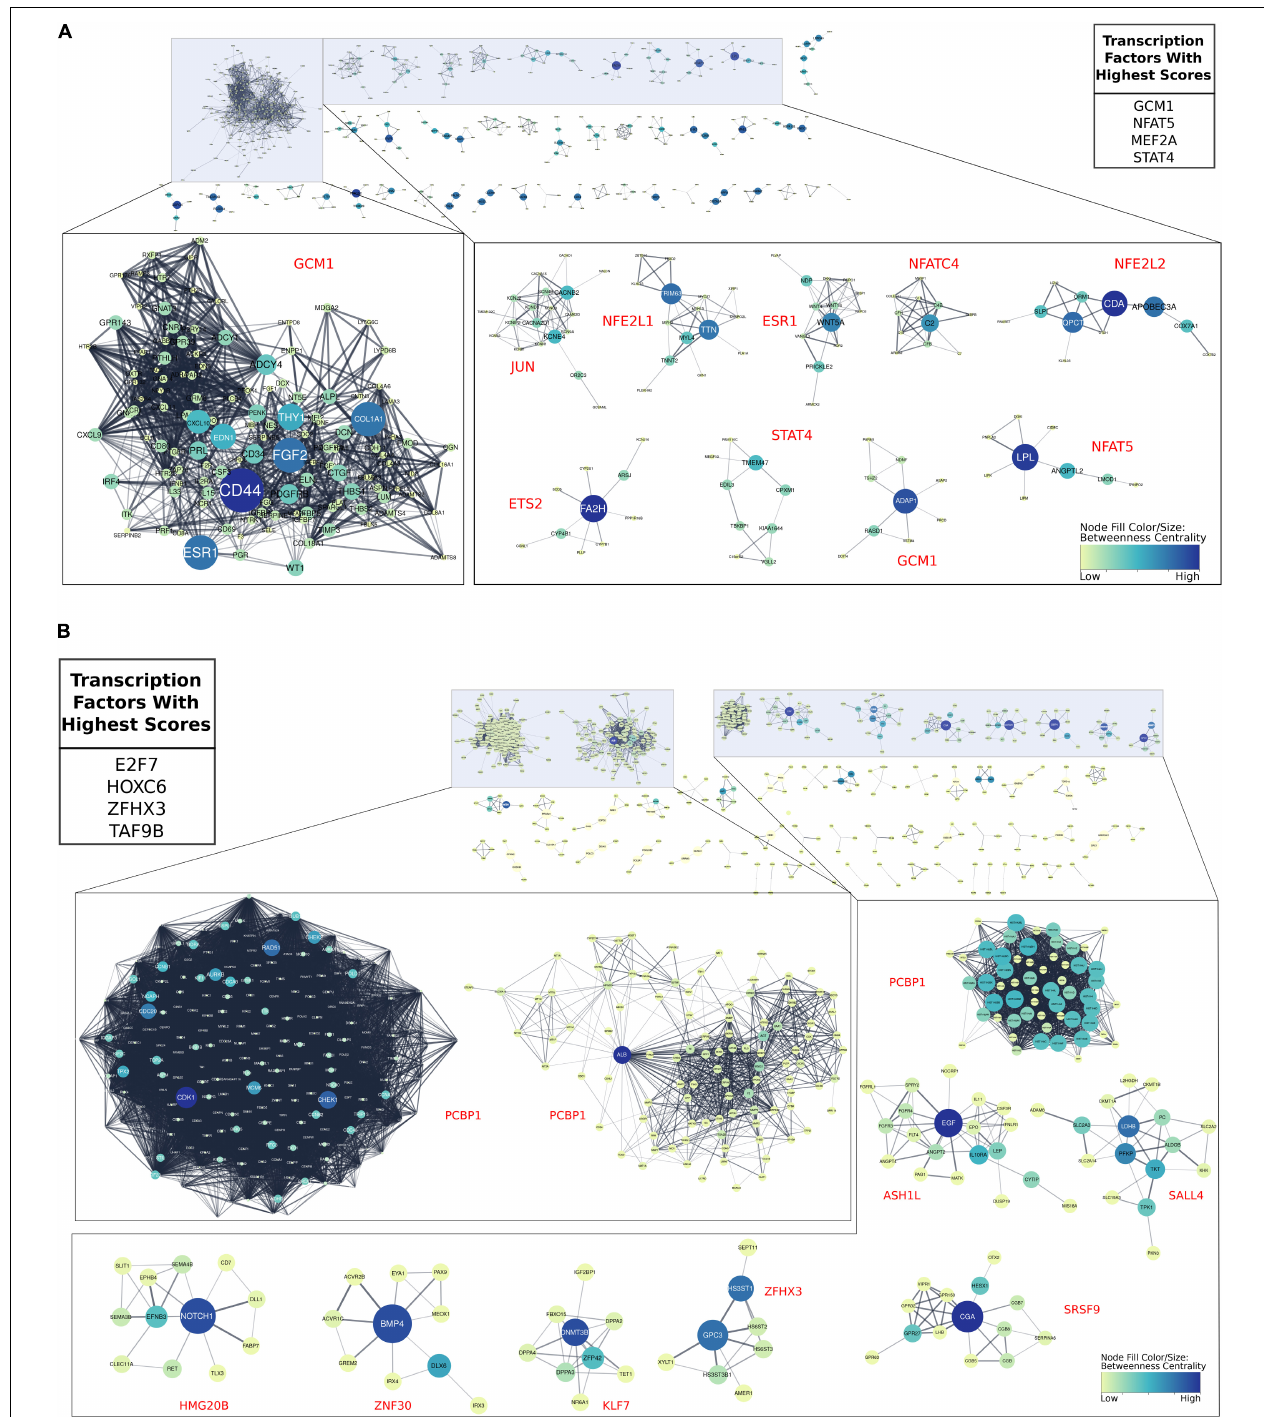
FIGURE 8 | Gene regulatory networks involved in EVT maturation. All gene regulatory subnetworks were created by clustering STRING networks of up- and down-regulated genes in term EVT compared with first trimester EVT. (A) All subnetworks created from genes up-regulated in term EVT compared with first trimester EVT. The top 10 largest subclusters are enlarged. The top four transcription factors (TFs) with the highest summed scores for all genes in the comparison are shown in the top right table. (B) All subnetworks created from down-regulated genes in term EVT compared with first trimester EVT. The top 10 largest subclusters are enlarged. The top four TFs with the highest summed scores for all genes in the comparison are shown in the top left table. For both analyses, the red TF names alongside each subnetwork are those with the highest importance scores in that subnetwork. Subnetwork node sizes and colors are determined by the nodes calculated betweenness centrality